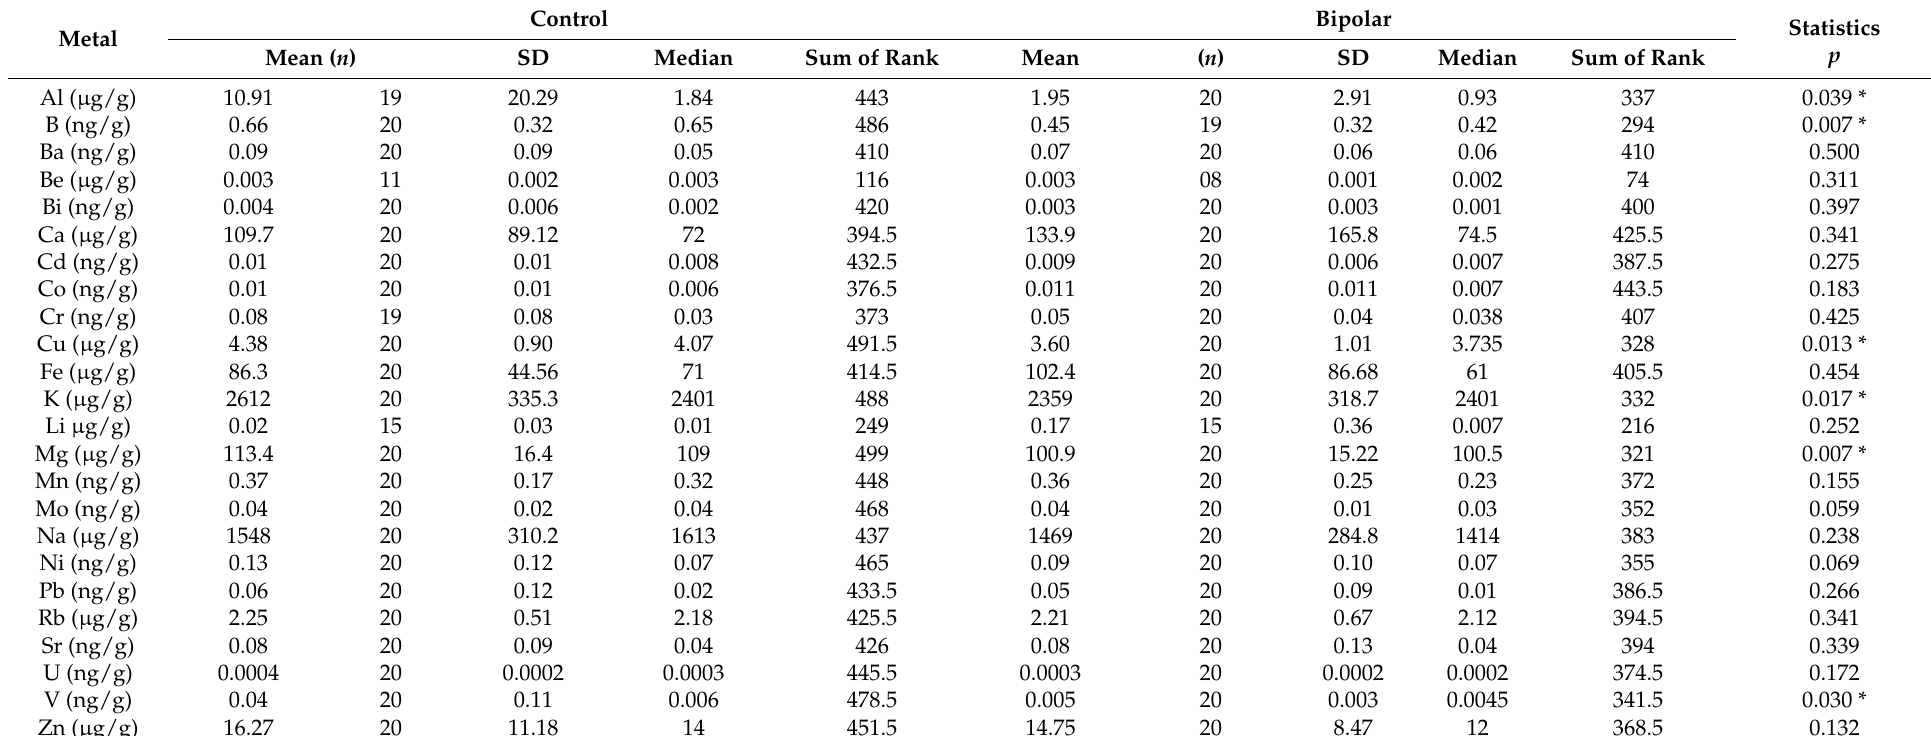
Table 4. Elemental concentrations in brain samples of BD and psychiatrically healthy